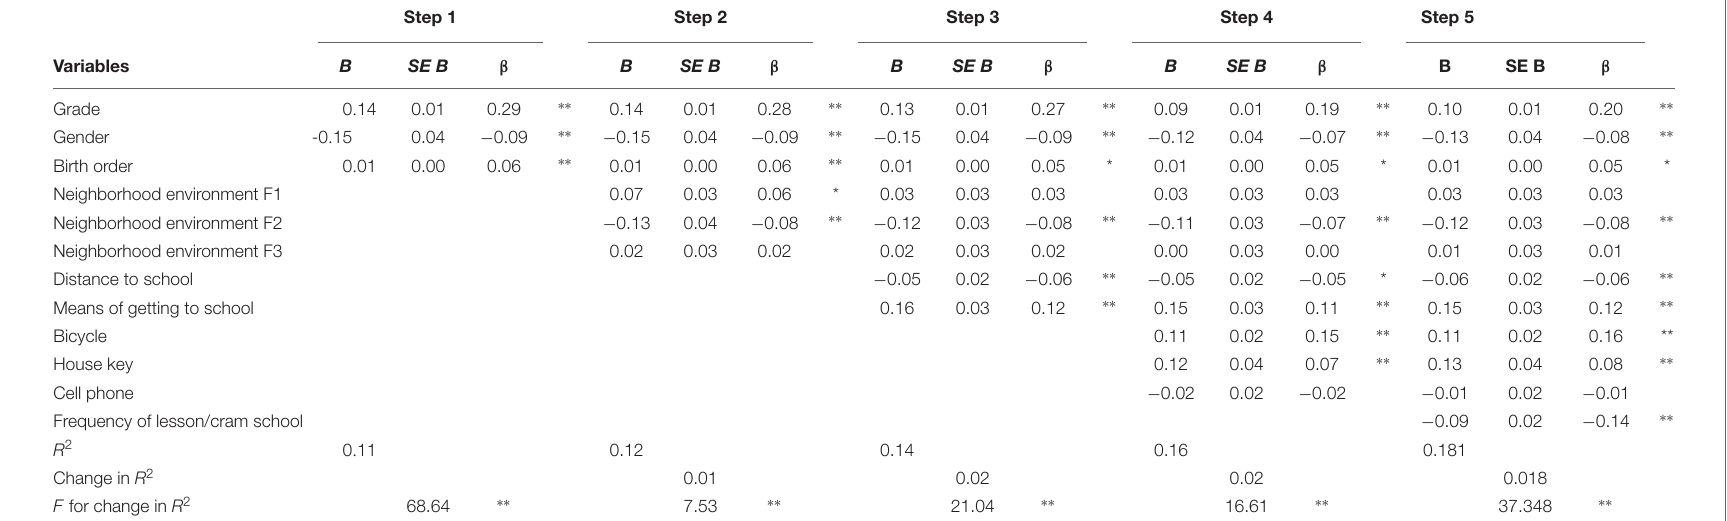
TABLE 11 | Results of hierarchical multiple regression analysis predicting the second factor of children’s independent